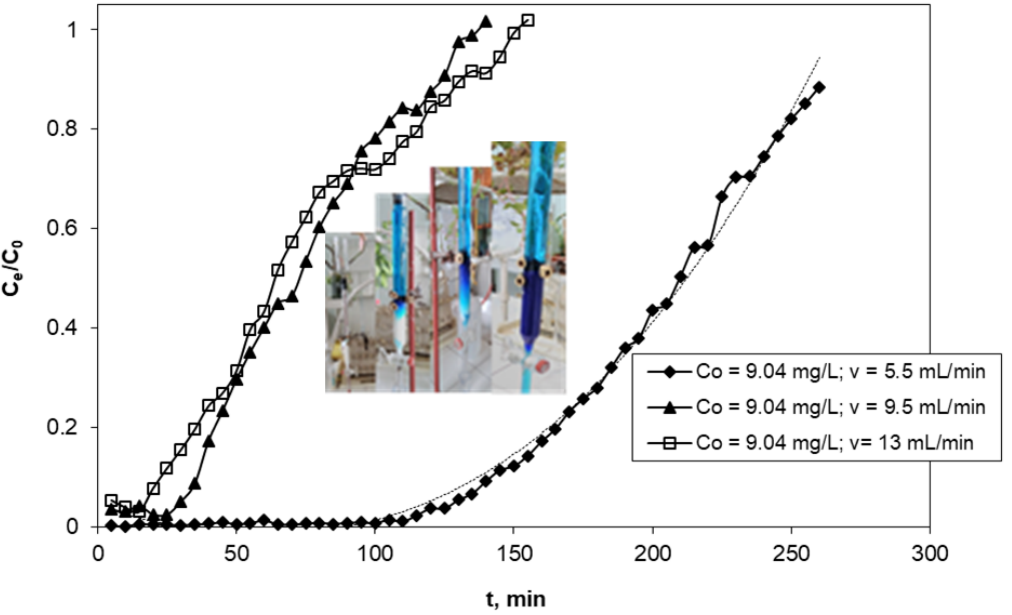
Figure 2. Breakthrough curve of Methylene Blue dye biosorption in a fixed-bed column filled with granulated Cellets 200 cellulose. Operating conditions: T = 20 °C, C 0 = 9.04 mg/L.